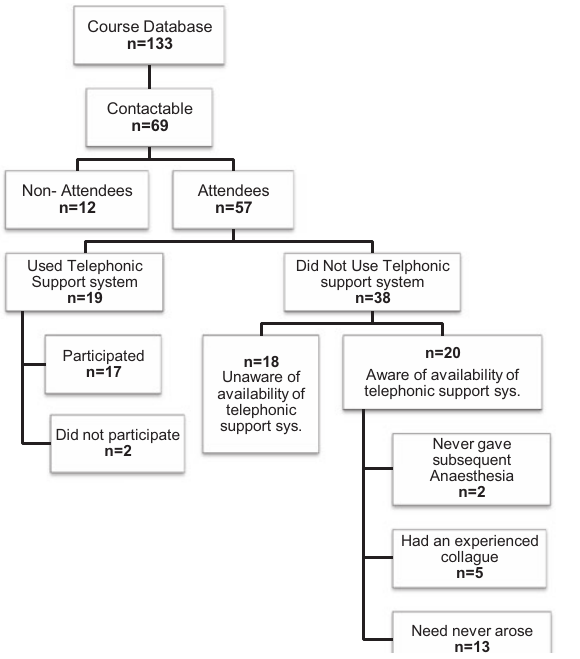
Figure1: Breakdown of the 133 doctors on the In-reach Course